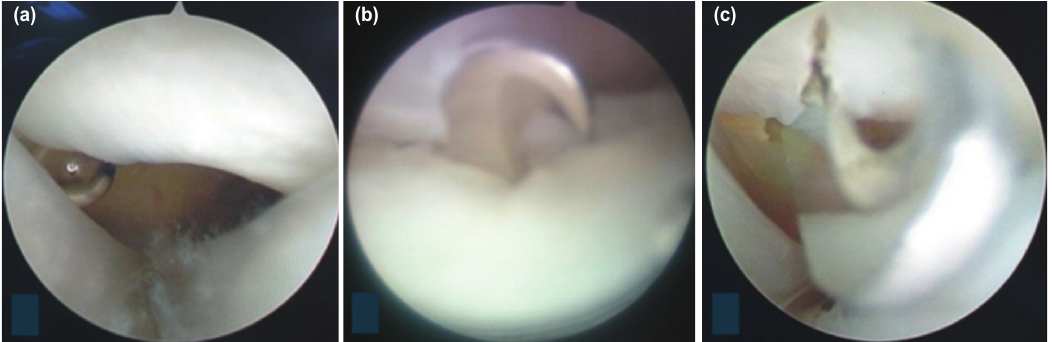
In operation: (a) Transverse carpal ligament before transection, (b) being transected using a reverse cutting blade, and (c) after Fig. 2: transection.